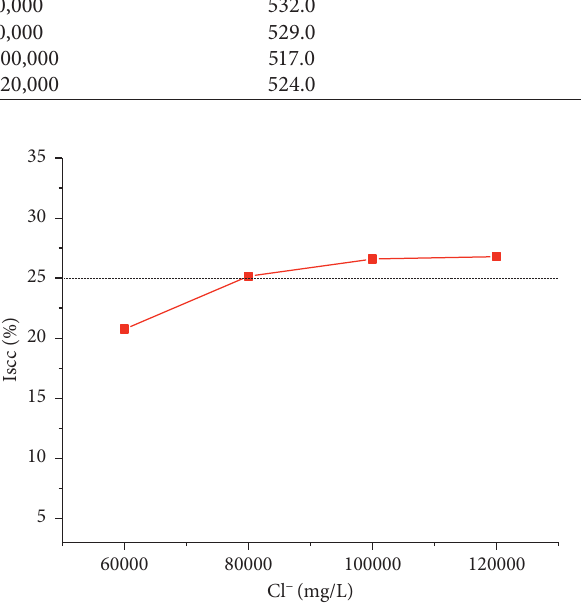
Figure 10: SEM images of fracture surface morphology of tensile test coupons (Pco (b) Cl − � 80,000mg/L. Table 7: Main mechanical properties of 316L stainless steel at different Cl − concentrations. Cl − (mg/L)